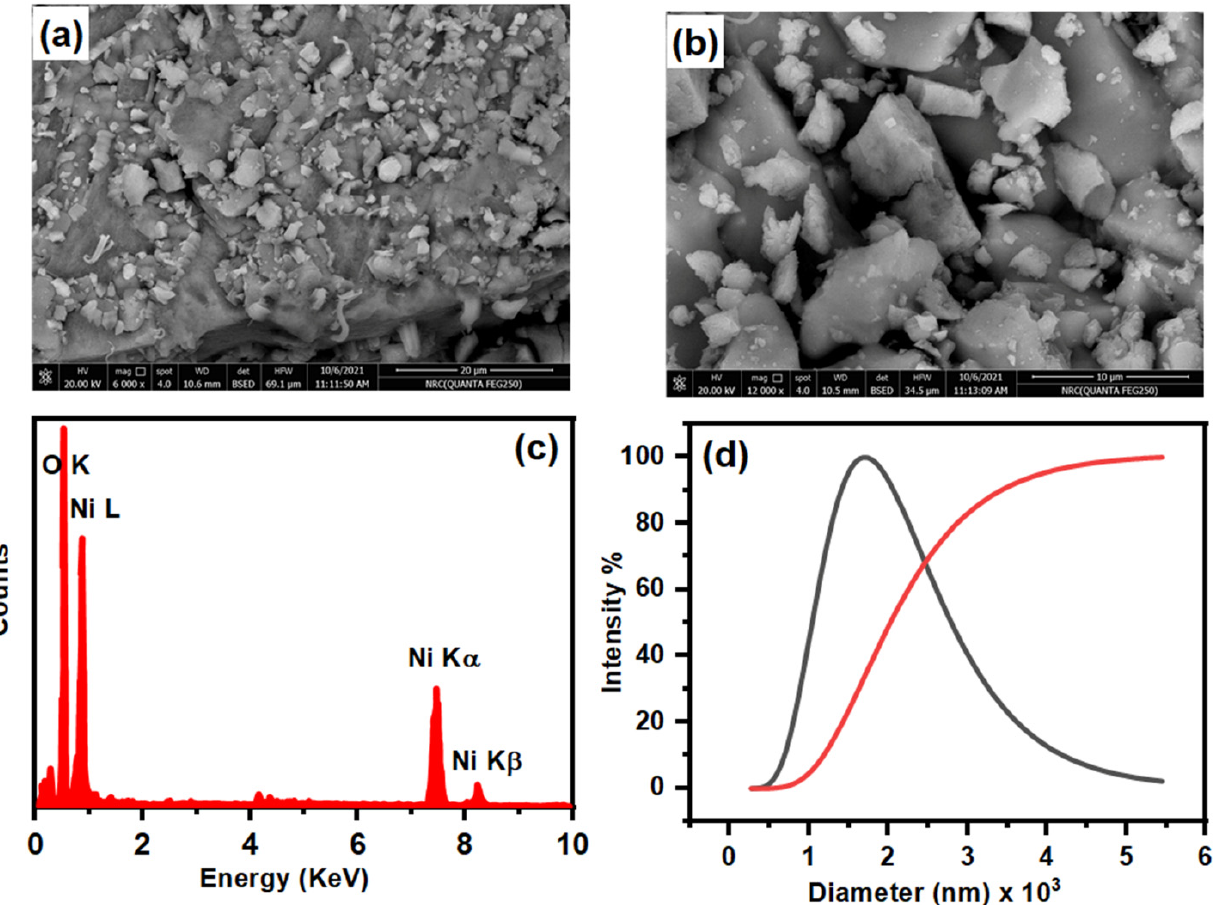
Figure 2. ( a , b ) FE-SEM images ( c ) Energy Dispersive Spectroscopy (EDS) and ( d ) Particles size distribution measured by DLS for Ni(OH) 2 -NC.